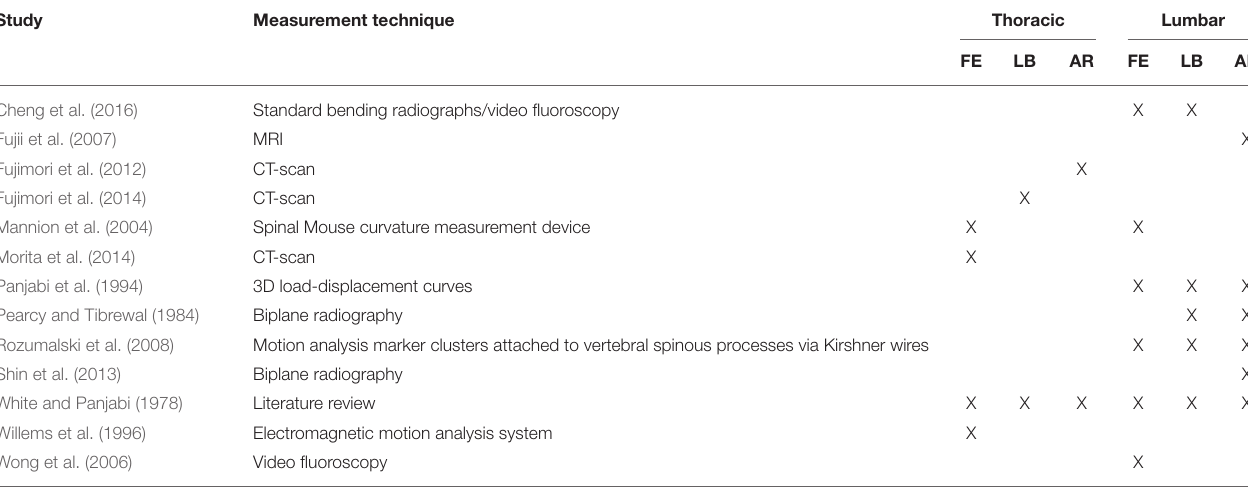
TABLE 1 | List of all studies used to estimate the intervertebral motion ratios in the thoracic and lumbar spines.